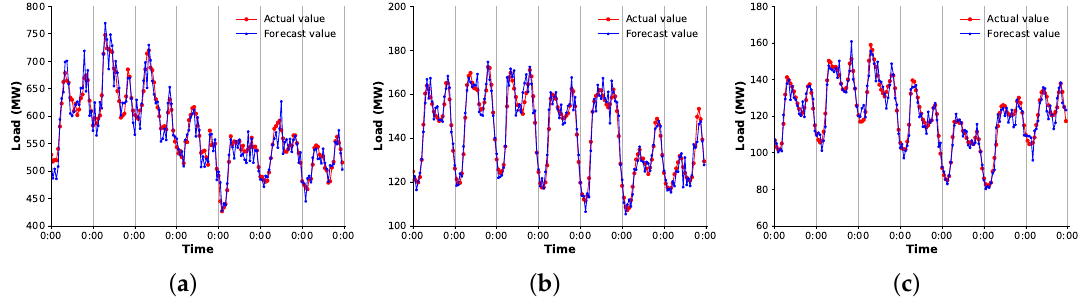
Figure 7. Forecast results for different zones. The data from ( a ) PAPWR, ( b ) RECO, and ( c ) UGI in March 2019.